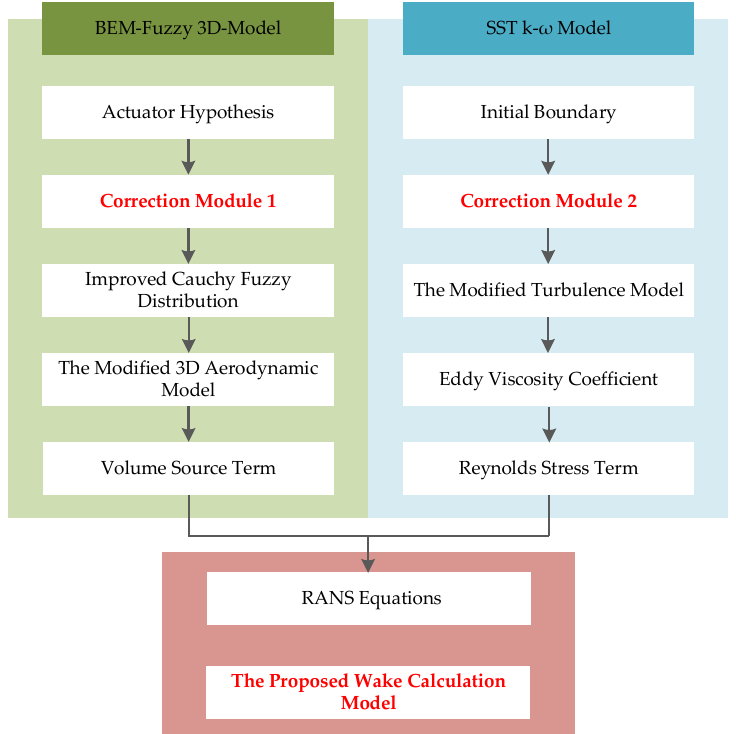
Figure 2. The overall framework of the modified Reynolds-averaged Navier–Stokes-based wind turbine wake model.